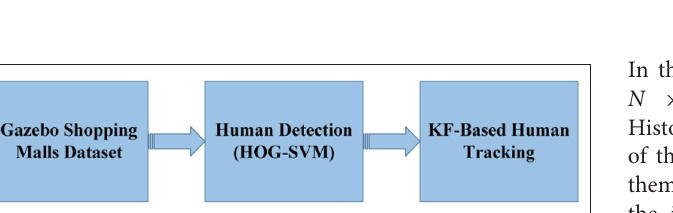
FIGURE 3 | Application steps of human tracking with the ground robot (Using the frames obtained by Turtlebot moving in the Gazebo Shopping Malls environment, feature extraction and human detection are applied with the help of HOG-SVM. As a result, humans in the environment are detected and marked. Finally, KF-based human tracking is performed, which provides the next position estimation of the